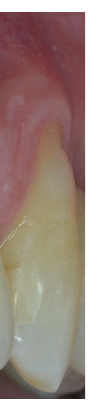
Figure 4: The composite restoration is reshaped at the maximum root coverage